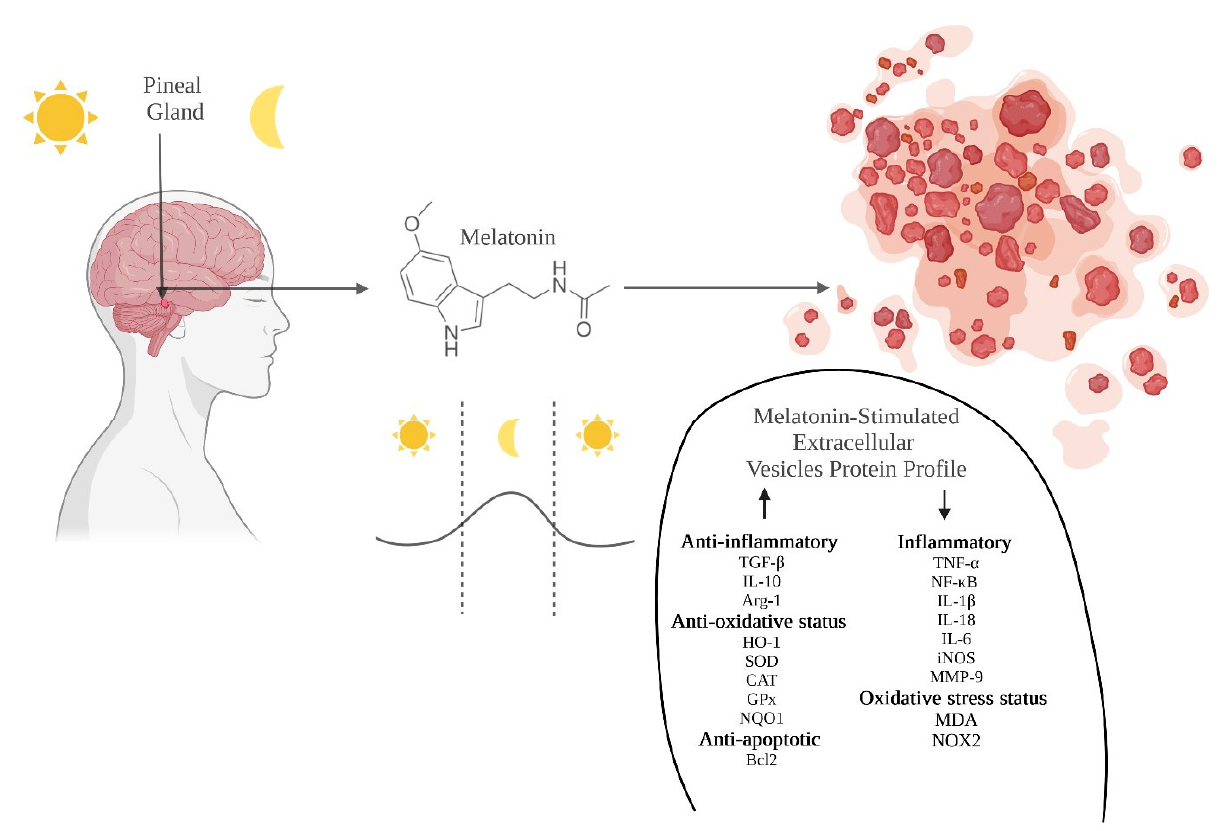
Figure 2. Circadian rhythms in regulation of melatonin-dependent secretion of the EVs. Melatonin is a ubiquitous molecule, synthesized in the pineal gland, and has myriad biological functions which primarily lead to the regulation of the endocrine circadian rhythm of the body. The presence of melatonin in the cellular environment changes the molecular composition of EVs. Melatonin is characterized by anti-inflammatory functions. The connection of EVs and melatonin represents a promising therapeutic instrument [191–195].